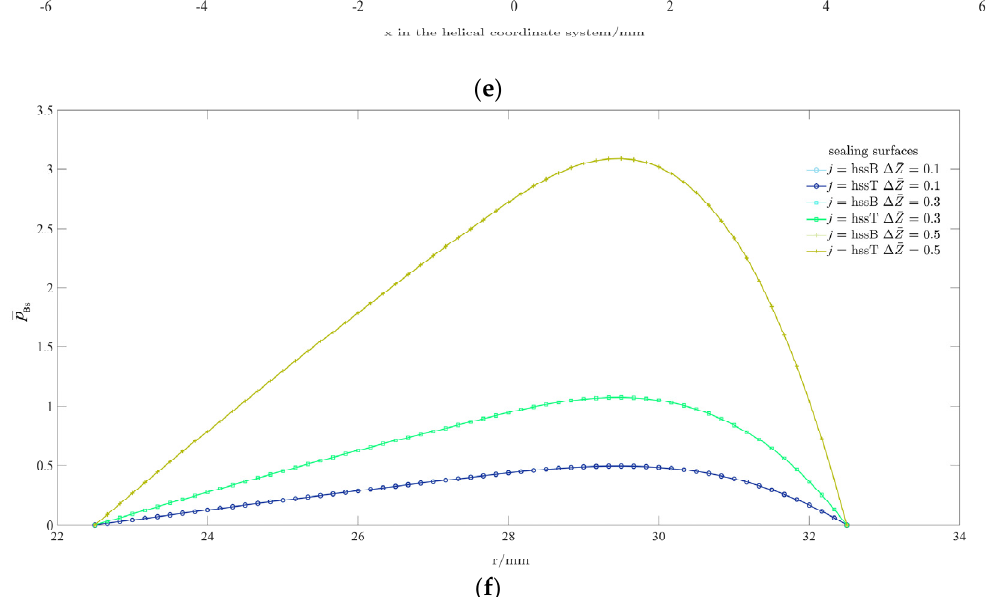
Figure 5. The variations of the steady pressures in the x (or r ) direction. ( a ) P Ts , x , chambers; ( b ) P Ts , r , chambers; ( c ) P Bs , x , chambers; ( d ) P Bs , r , chambers; ( e ) P Bs , x , sealing surfaces; ( f ) P Bs , r , sealing